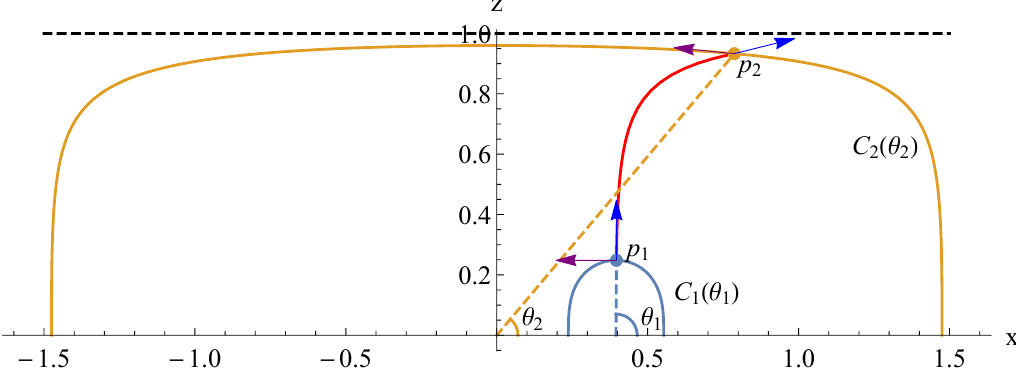
Figure 11 . The schematic demonstration of the EWCS. The p 1 and p 2 are the intersection of the minimum surface connecting those two minimum surfaces. The solid blue curve (parametrized by θ 1 ) and solid orange curve (parametrized by θ 2 ) are minimum surfaces. The thick purple curve is the minimum surface connecting p 1 and p 2 . The blue arrows at the p 1 and p 2 are the tangent (cid:0) ∂ (cid:1) a (cid:12) (cid:12) vectors (cid:12) ∂z